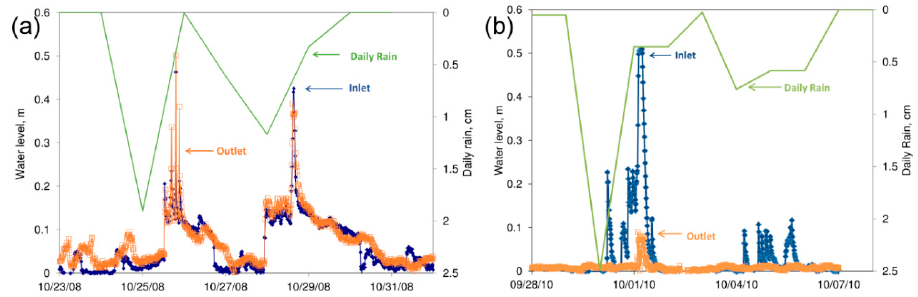
Figure 3. Water level response to storm events ( a ) before and ( b ) after retrofitting.